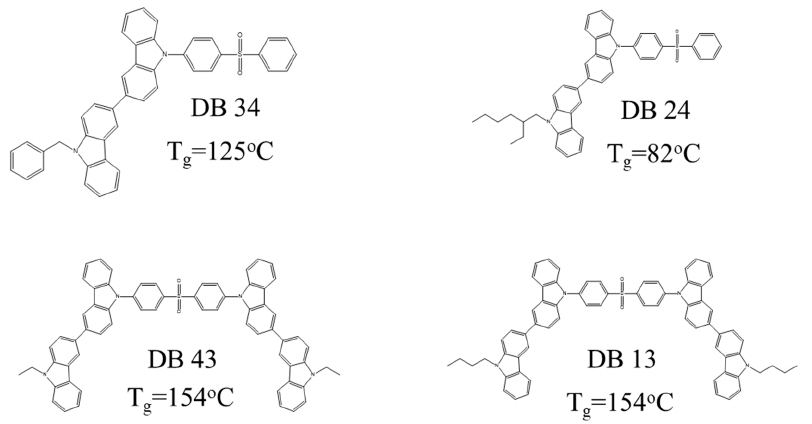
Figure 2. Exact chemical structures of the bicarbazole-benzophenone-based derivatives DB34, DB24, DB43, and DB13.